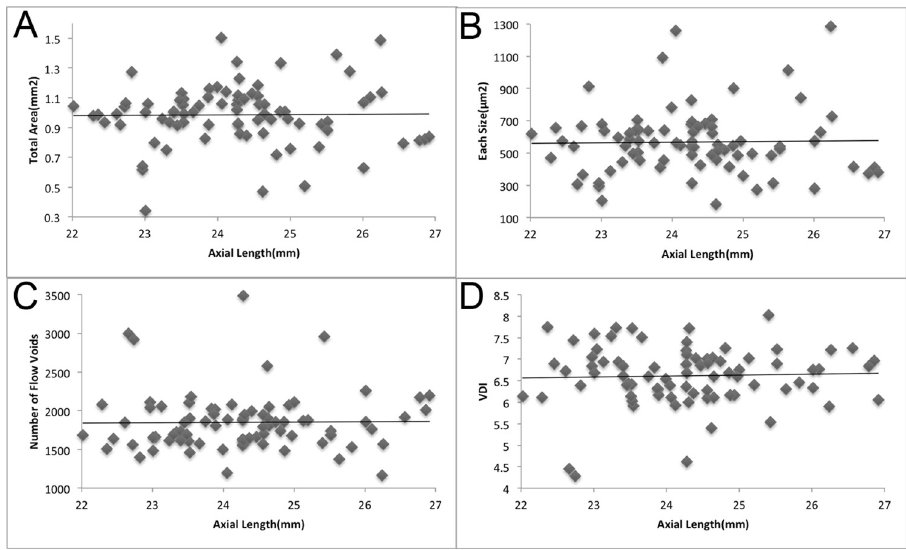
Fig 5. Correlations among axial length, total area, size, and number of flow voids, and the VDI. A. Correlation between the total area of flow voids and axial length. No significant correlation is observed between the total area of flow voids and axial length (p = 0.905). B. Correlation between the size of flow voids and axial length. No significant correlation is observed between the size of flow voids and axial length (p = 0.858). C. Correlation between the number of flow voids and axial length. No significant correlation is observed between the number of flow voids and axial length (p = 0.907). D. Correlation between the VDI and axial length. No significant correlation is observed between the VDI and axial length (p =